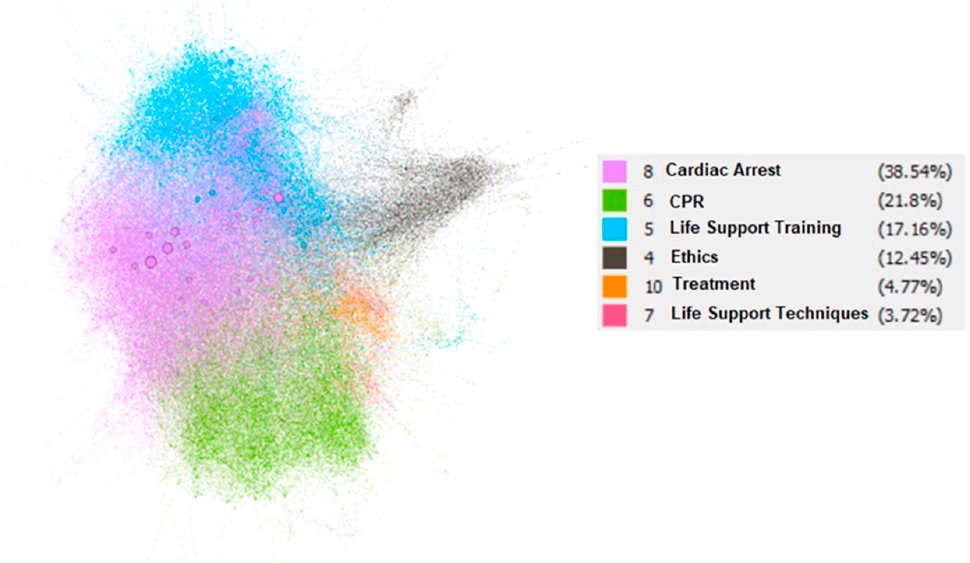
Figure 5. Representation of the 6 categories identified.